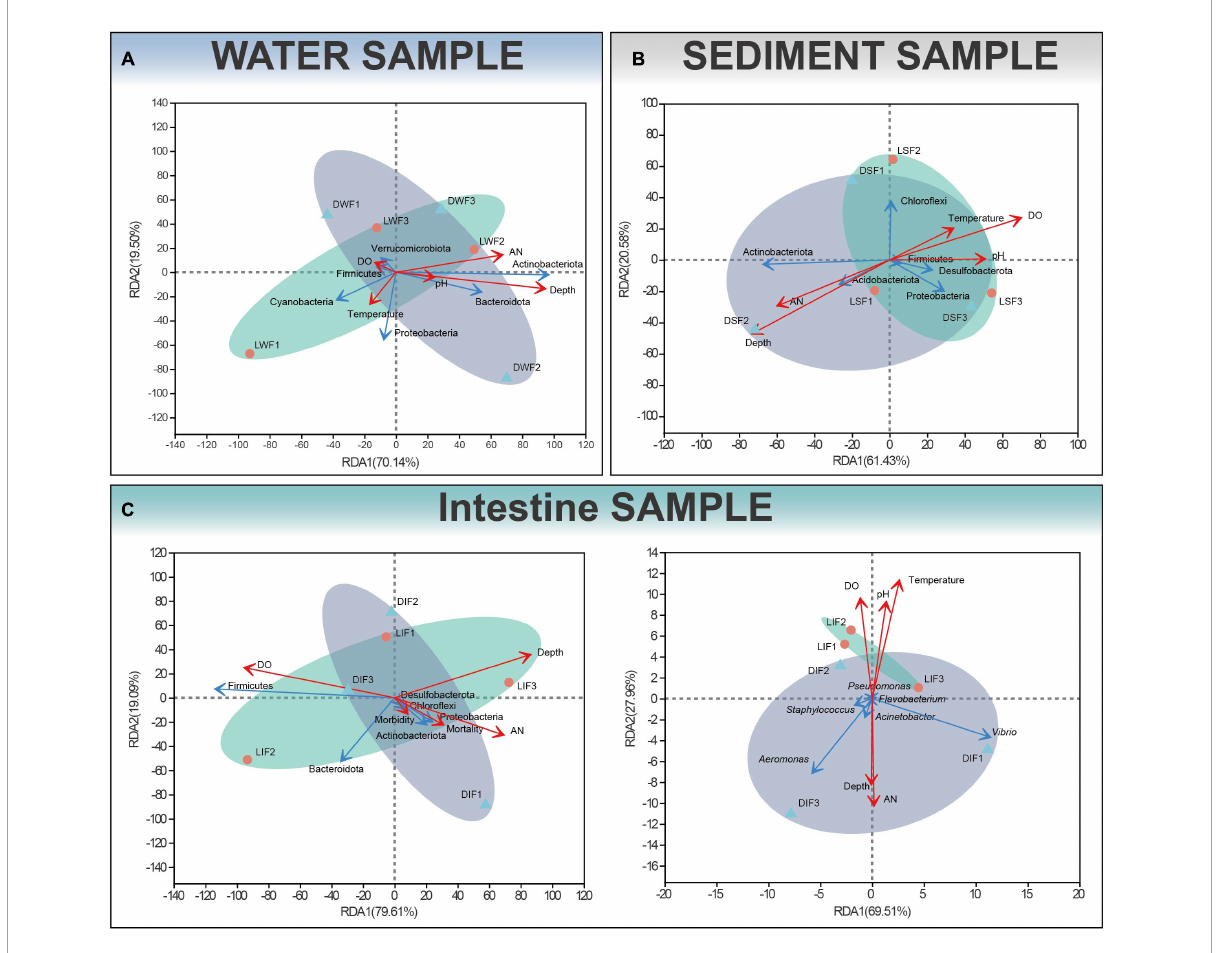
FIGURE6 Redundancy analysis (RDA) of the relationship between bacterial and environmental factors in water (A) , sediment (B) and intestinal (C) samples for phylum levels and potentially pathogenic bacteria. Depth, AN and DO indicate water depth, total ammonia nitrogen and dissolved oxygen, respectively. Red and blue arrows represent environmental variables and bacteria